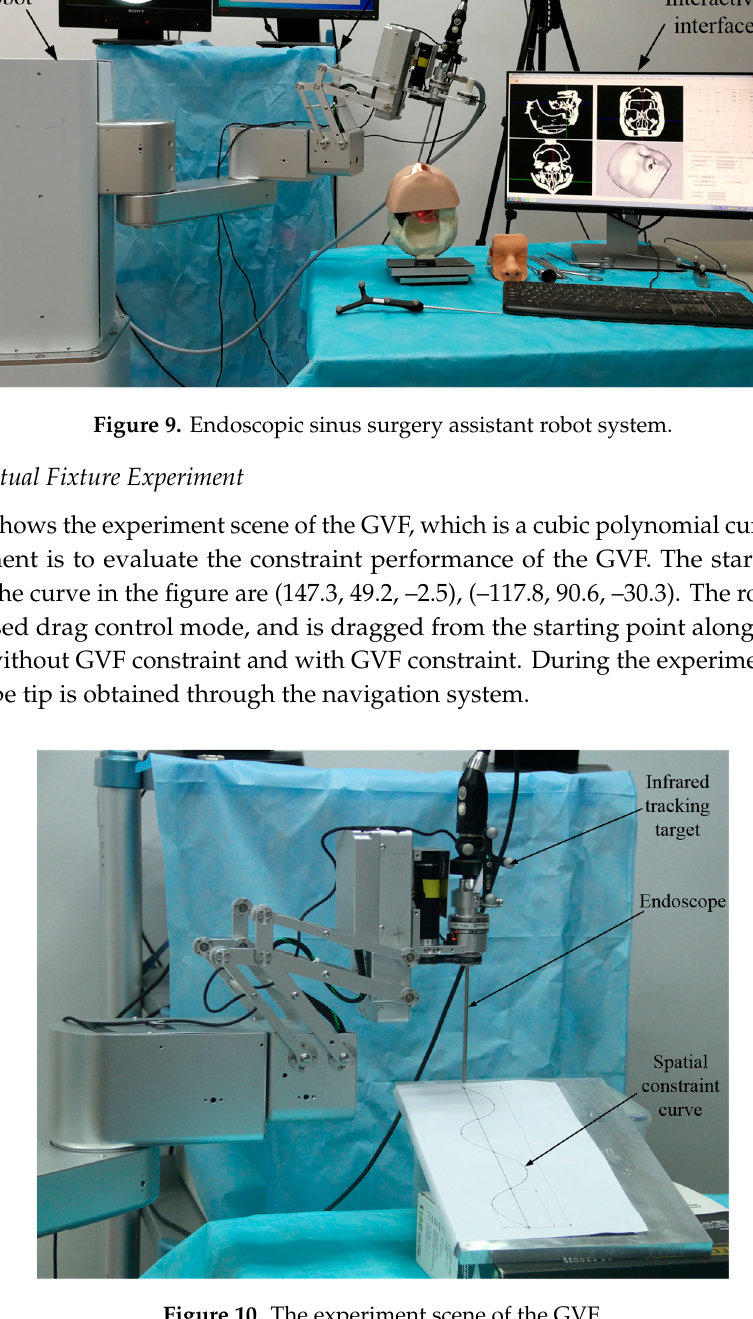
Figure 10. The experiment scene of the GVF.